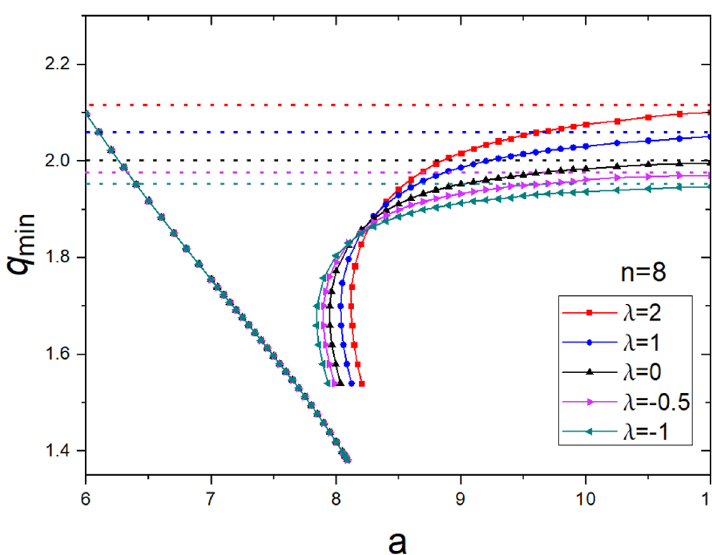
Figure 4 . Phase diagram of solutions with the minimal charge q min as a function of the amplitude a with profile n = 8 , for several values of coupling parameter λ